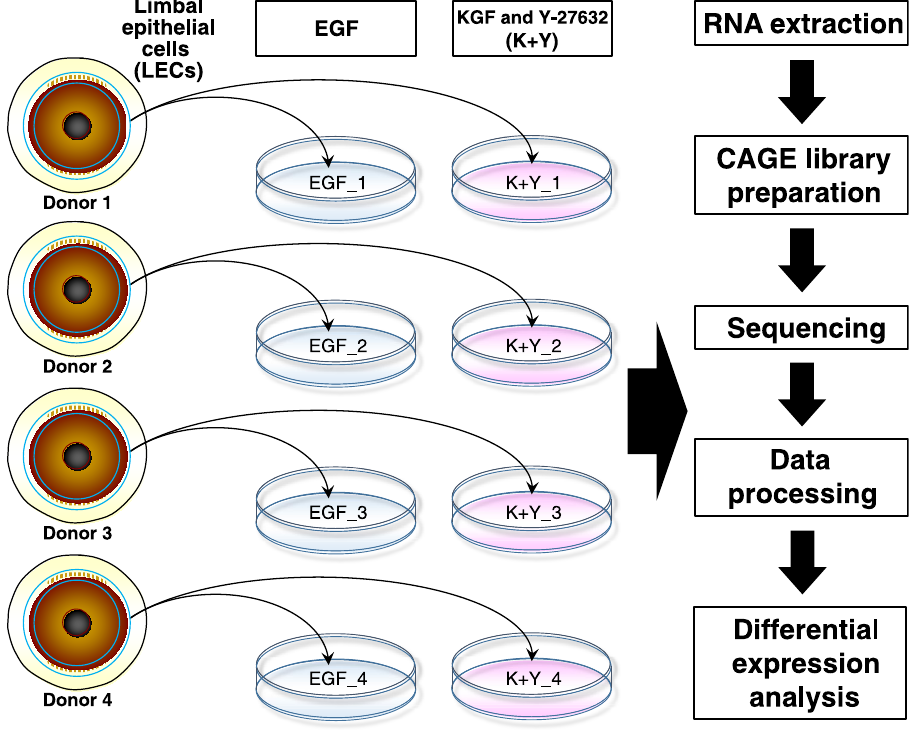
Figure 1. Study design. Distinct limbal epithelial cells (LECs) derived from 4 donors were divided into 2 groups: LECs cultured with EGF (blue) and LECs cultured with KGF and Y-27632 (K + Y, pink). RNA was extracted from LECs and CAGE analysis was